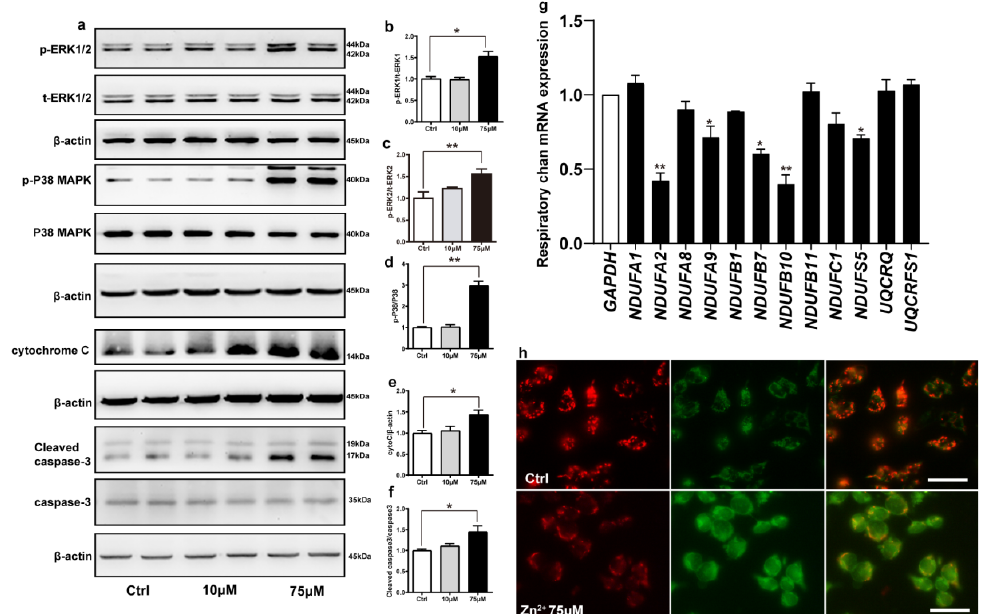
Figure 5. Zn 2+ activates the ERK/P38 signaling pathway and causes mitochondrial damage in HEK293 α -synuclein-DsRed cells. ( a – e ) HEK293 α -synuclein-DsRed cells were treated with 10 or 75 μ M ZnSO 4 for 12 h. The p-ERK1 ( a , b ), p-ERK2 ( a , c ), p-p38 ( a , d ), cleaved caspase 3 ( a , f ) levels and the total protein levels of ERK1/2, p38, caspase 3 and expression levels of cytochrome C ( a , e ) were determined via Western blotting with β -actin as an internal control (( a ), representative pictures; ( b – f ), quantification). ( g ) The mRNA expression levels of mitochondrial respiratory chain complex I and III subunits were determined via qRT-PCR using GAPDH as the internal controls. ( h ) JC-1 staining was used to detect the changes in mitochondrial membrane potential after HEK293 α -synuclein-DsRed cells were treated with 75 μ M ZnSO4 for 12 h. Color dye changes reversibly from red to green as mitochondrial membranes become depolarized. All data from at least three independent experiments are represented as the means ± SEM. * p < 0.05, ** p < 0.01 with respect to the control group.